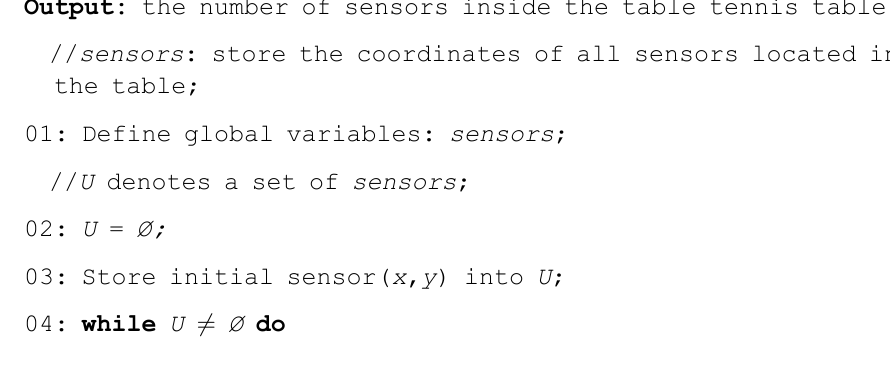
Output: the number of sensors inside the table tennis table // sensors : store the coordinates of all sensors located inside the table;